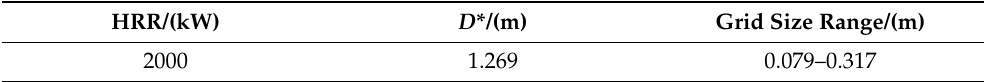
Table 2. The grid size range with HRR.